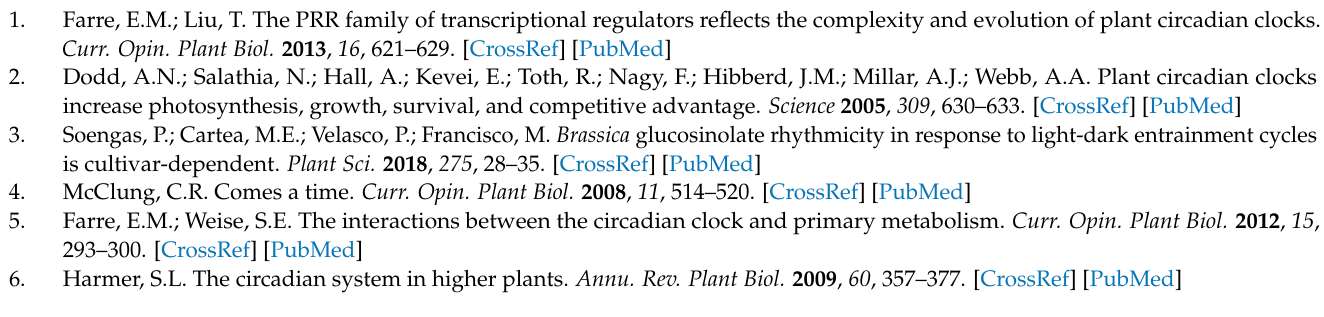
Table S3: The circadian clock genes showing differential expression in GK1 line compared to DH03 wild type, Table S4: The light regulation related genes showing differential expression in GK1 line compared to DH03 wild type, Table S5: GO analysis of 2 fold down regulated transcriptome in